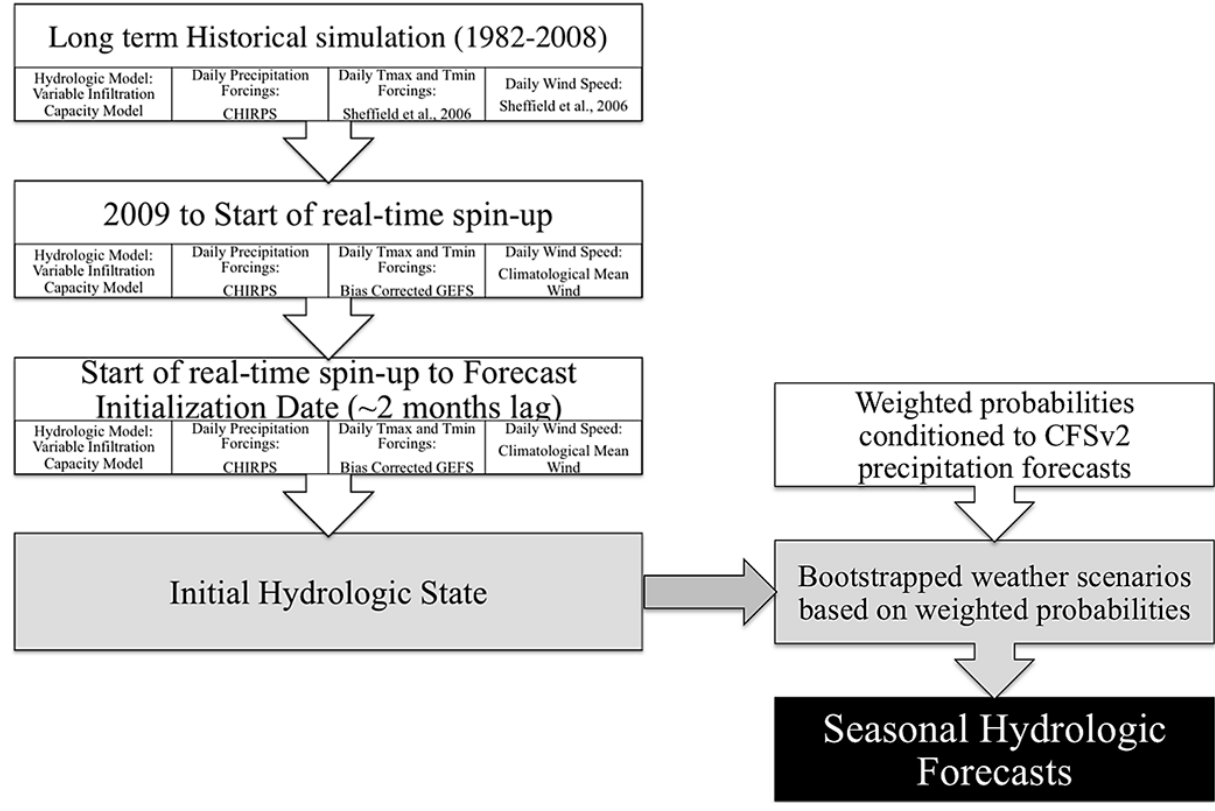
Figure 2. Schematic diagram summarizing the approach, data, and models used for the development and implementation of the current version of the seasonal agricultural drought forecast